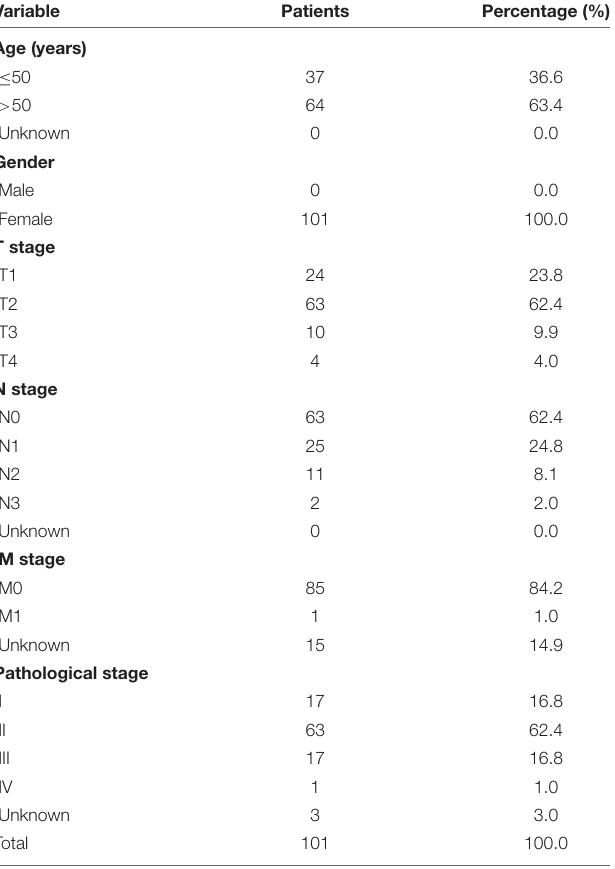
TABLE 1 | The clinical characteristics of triple negative breast cancer patients in the training cohort. Variable